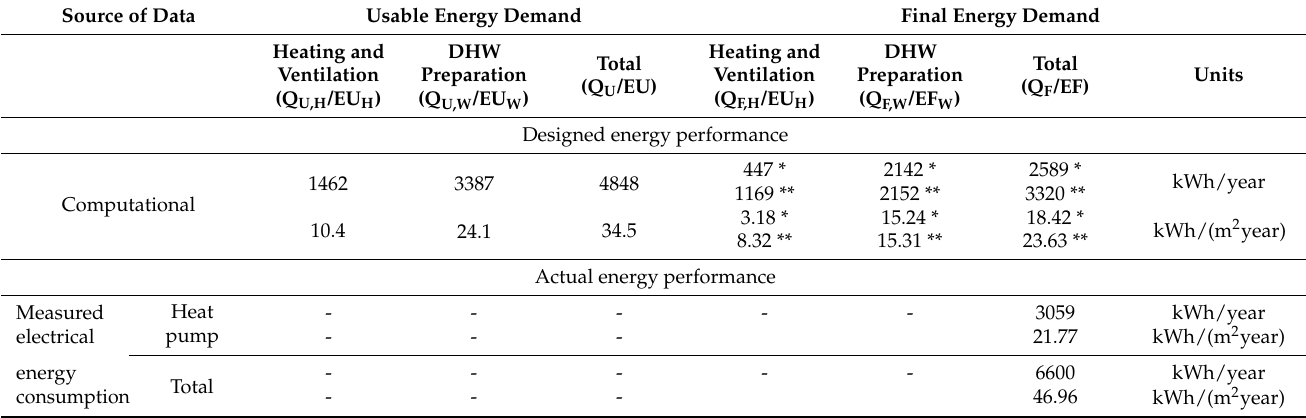
Table 5. Designed and actual energy performance of analyzed